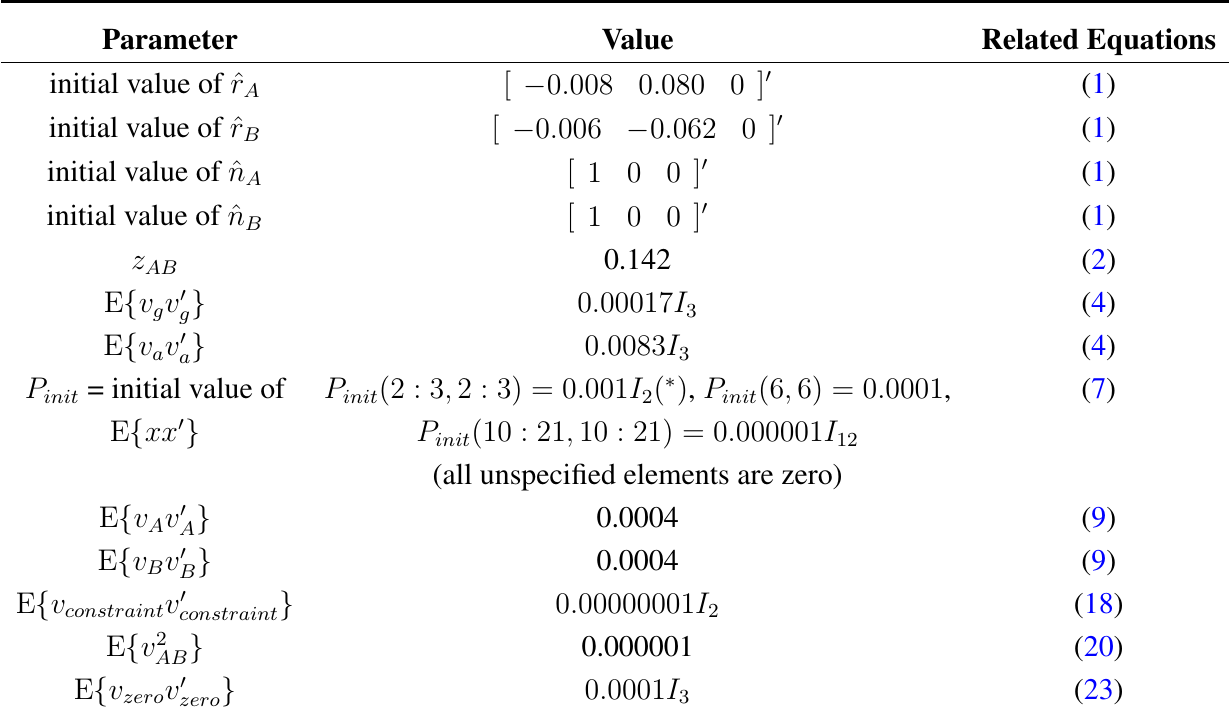
Table 1. Parameters in the proposed